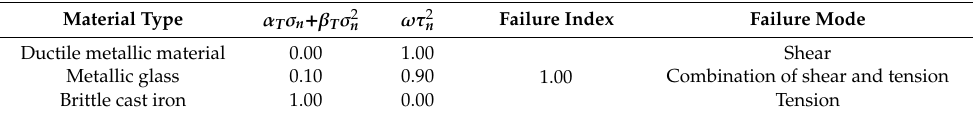
Table 4. Failure modes under uniaxial tension